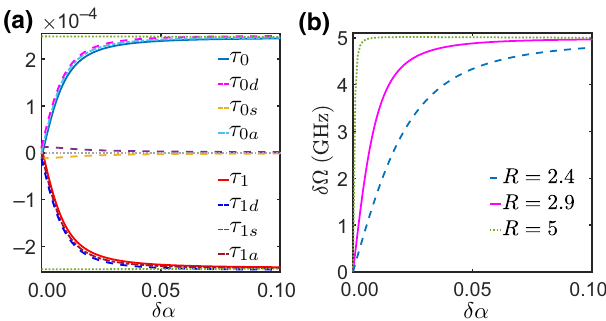
FIG. 4. (a) The total ( τ σ ), static ( τ σ s ), and dynamic ( τ σ d ) torques as a function of δα for θ = 0.01, (cid:7) 1 /(cid:6) = 0.1, and R = 2.9. The dotted lines correspond to the asymptotic behavior of the two contributions to the torque τ σ s and τ σ d for t h (cid:6) δα . The total torque evaluated analytically ( τ σ a ) from Eq. (15) shows excellent agreement with the numerical result (dotted-dashed lines). (b) The difference of the resonance frequencies in the two qubit states, δ(cid:7) = (cid:7) r ,0 − (cid:7) r ,1 , as a function of δα for α 2 = 1.1, = 25 GHz and several separations R = 2.4, 2.9, and 5. The (cid:7) 0 saturation of δ(cid:7) for even moderate separations indicates robust qubit detection. All plots are obtained using k F =